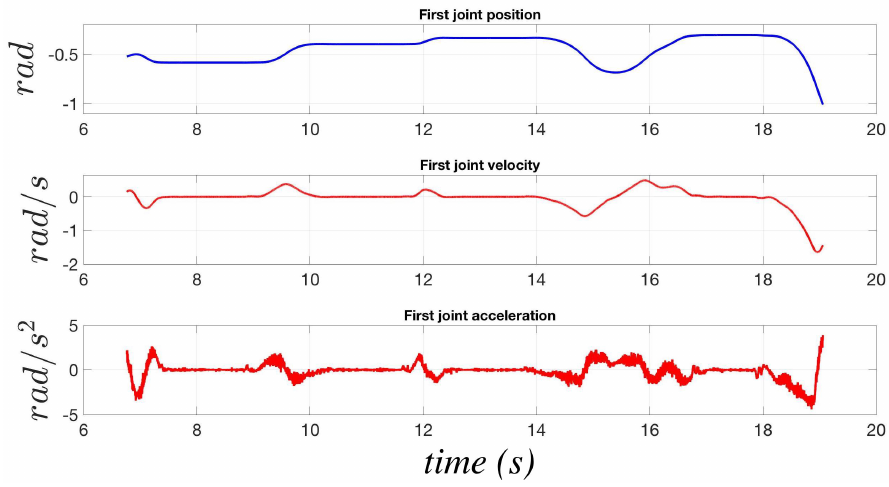
Figure 4. Position, velocity and acceleration of the first joint of the NJ4 170